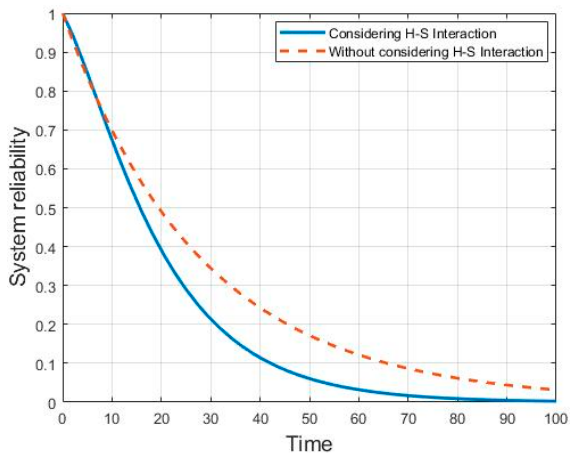
Figure 3. System reliability prediction with and without considering hardware-software interaction.